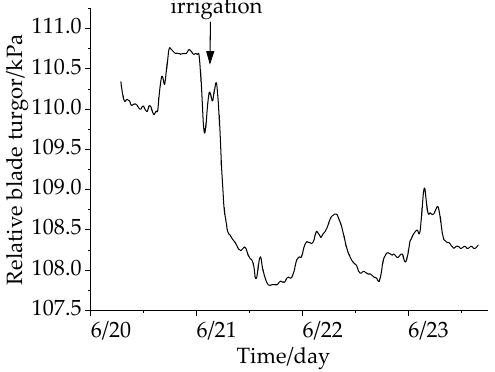
Figure 13. Change curve of swelling pressure after irrigation.